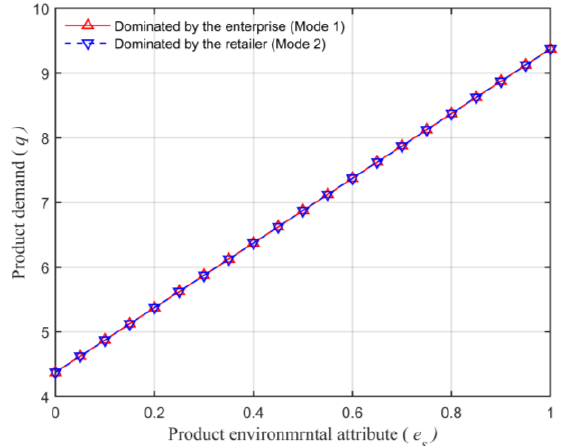
Figure 5. The relationship between the product environmental attribute and the product’s retail price.